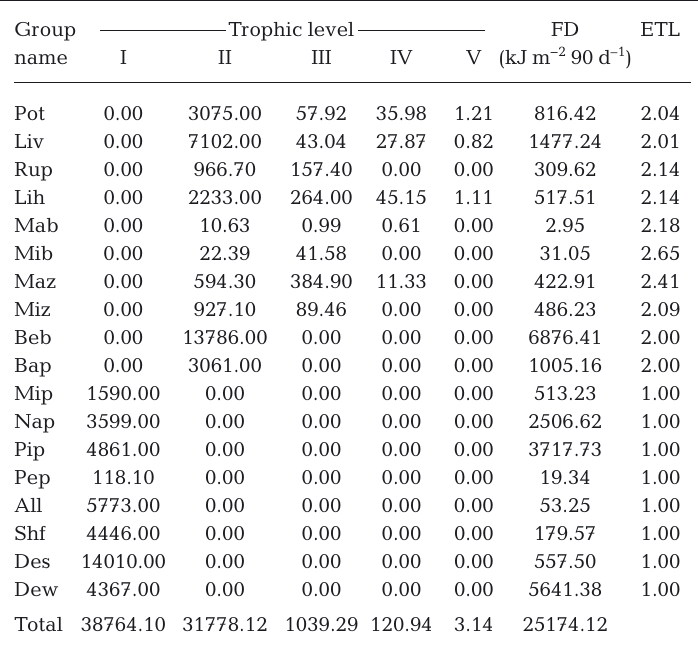
Table 3. Trophic flow matrix of the 4-species polyculture ecosystem according to model groups and trophic levels. Group names as in Table